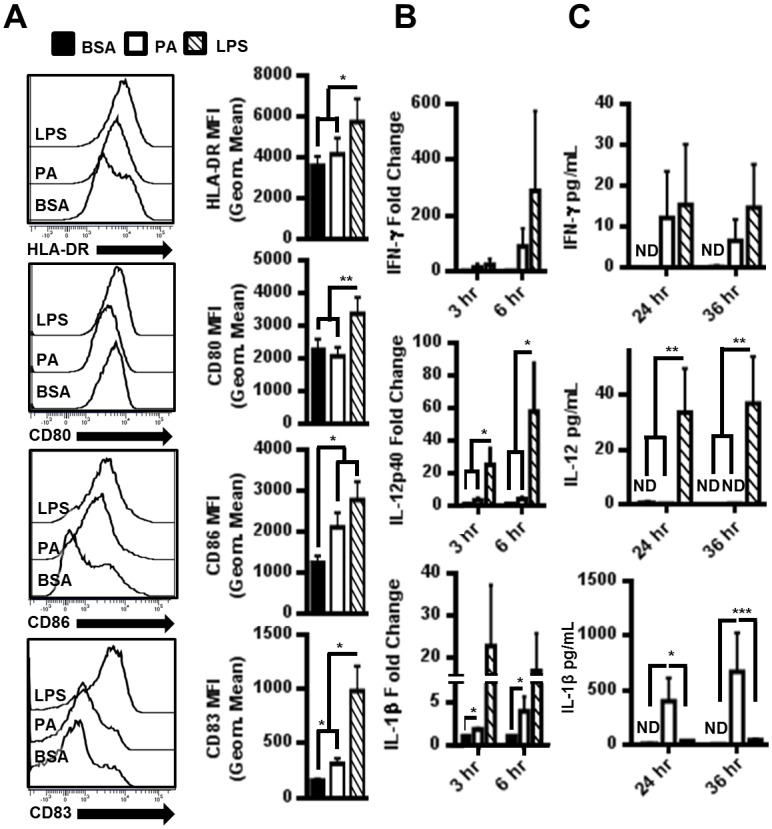
PA induced DC maturation and secretion of IL-1β.(A) PA upregulated DC activation and maturation markers. MoDCs were treated with 150μM PA for 12hrs. Representative histograms from 1 of 8 individual patient samples is presented, and the average geometric MFI for the indicated marker on CD11chi cells (MoDCs) from all 8 samples is graphed. (B) mRNA fold change in cytokines of MoDCs treated with 300μM PA (N = 8). (C) Quantification of cytokines secreted from MoDCs treated with 300μM PA (N = 4). ND = Not detectable.